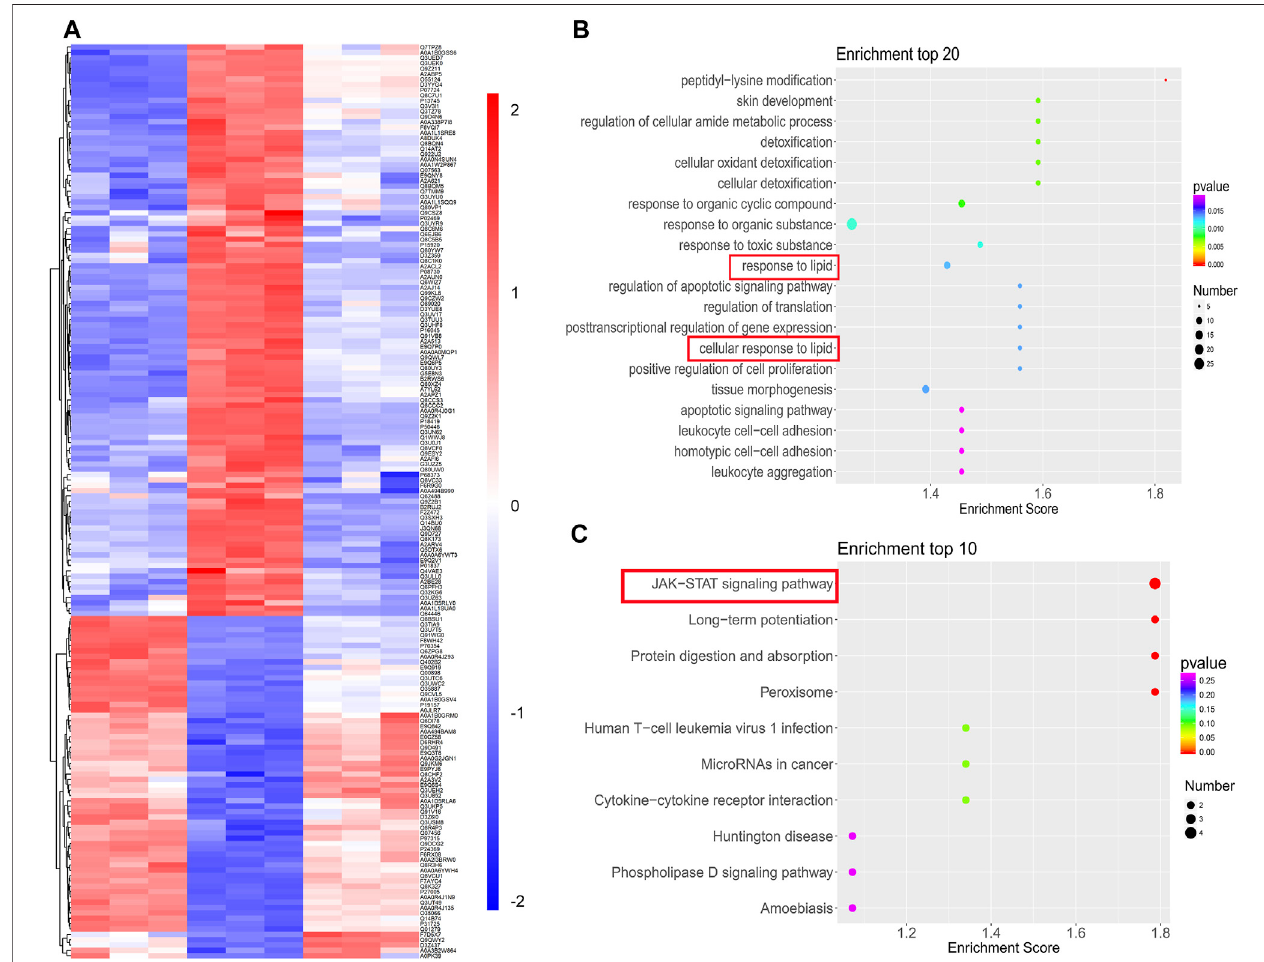
FIGURE 7 | TMT-based quanti fi cation of proteomes and analysis. (A) Hierarchical clustering of 171 common differentially expressed proteins. (B) Top 20 BP enrichment terms. (C) Top 10 KEGG pathway terms.